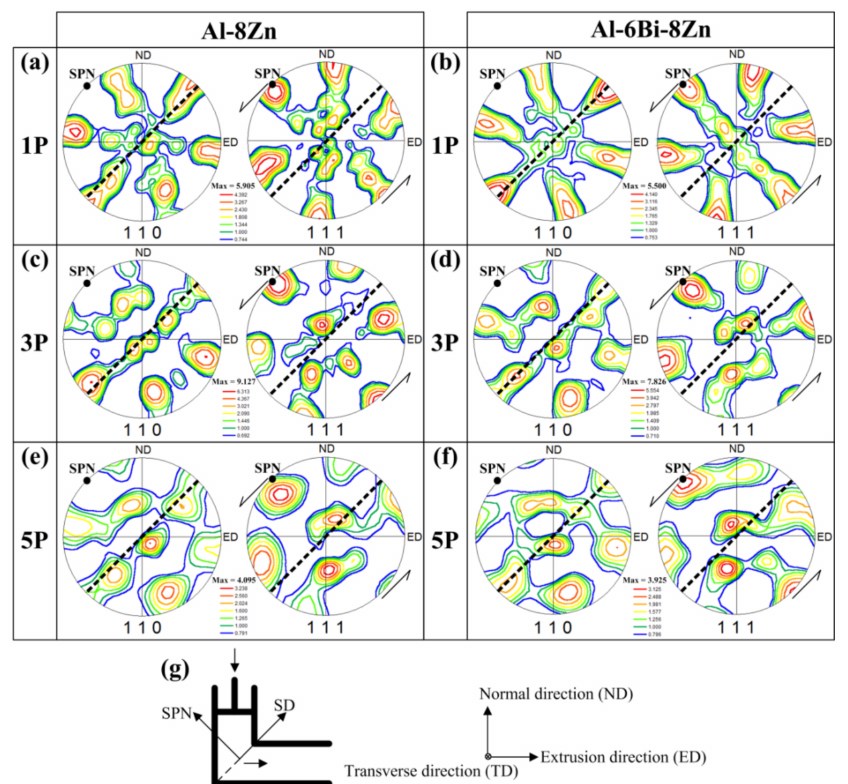
Figure 6. {1 1 0} and {1 1 1} pole figures of ECAP-processed Al-8Zn and Al-6Bi-8Zn alloys. ( a ) and ( b ) 1P, ( c ) and ( d ) 3P, ( e ) and ( f ) 5P, and ( g ) is a schematic of the ECAP die and its relevant coordinate system. The dotted lines in the pole figures indicate the ideal shear plane (SD and SPN are abbreviations for shear plane and shear plane normal).